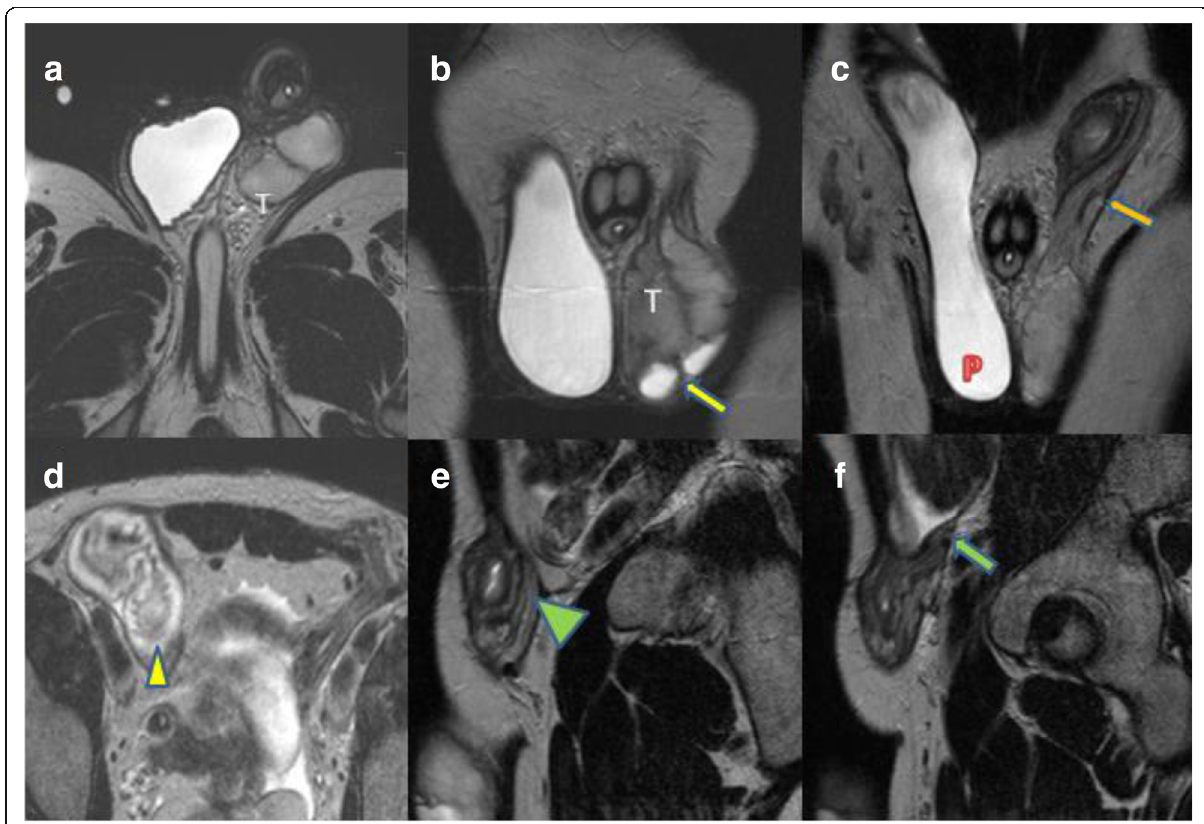
Fig. 2 MRI images of scrotum and pelvis. a Axial T2W image shows two testes in the left hemiscrotum ( ‘ T ’ ). b , c Coronal T2W images shows varicocele, two separate vas deferens from each testes (arrows) and right side patent process vaginalis ( ‘ P ’ ). d Axial T2W image shows right side inguinal hernia with bowel loop (arrow head). e , f Sagittal T2W images reveals two separate vas deferens (arrow head) which appears fused at its proximal end